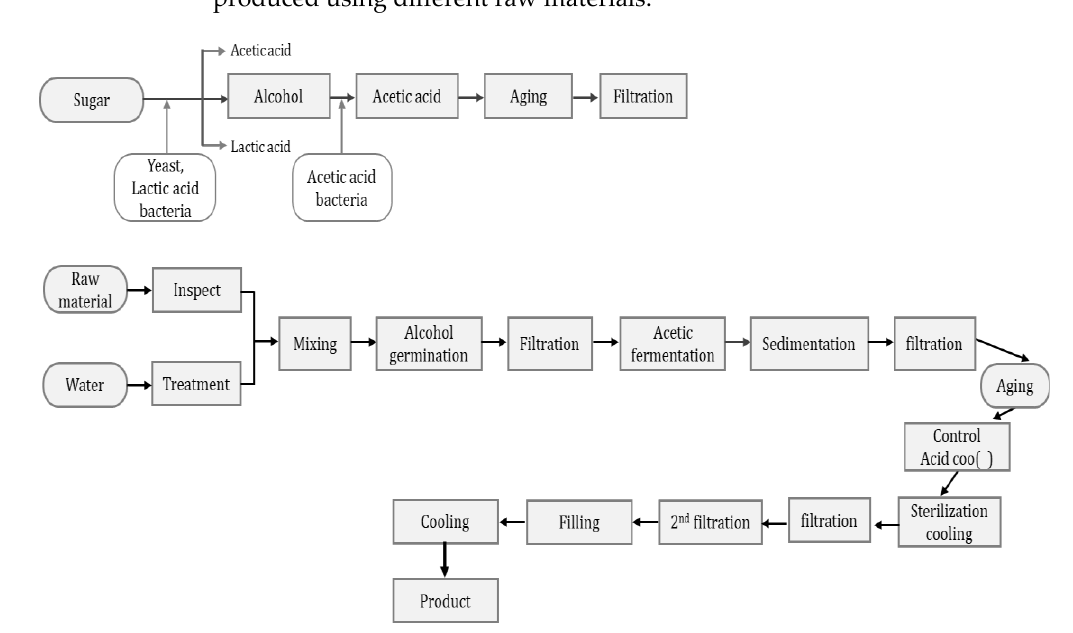
Figure 12. General preparation process for vinegar.